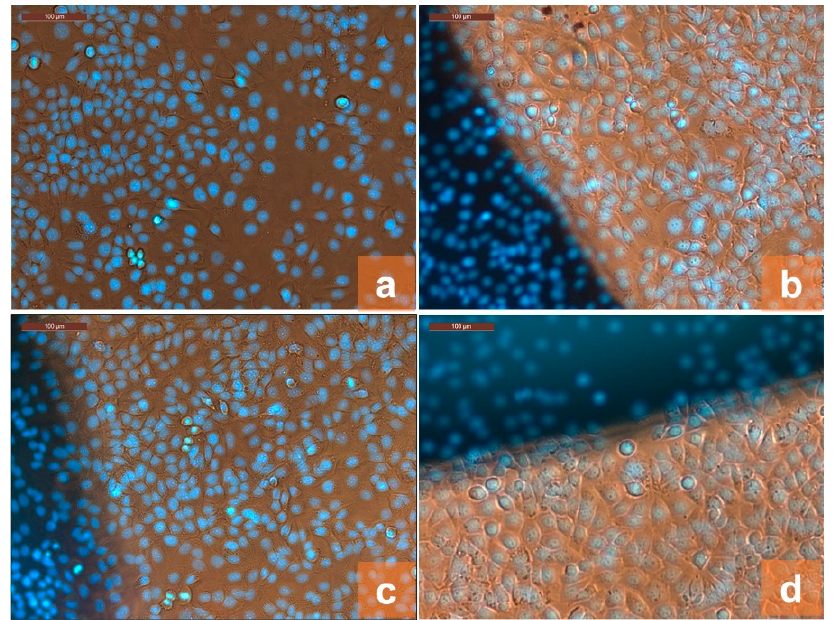
Figure 8. Microscopic images of DAPI-stained cells at 72 h of culturing in contact with PVA/CS-0 ( a ), PVA/CS-1 ( b ), PVA/CS-2 ( c ), and PVA/CS-0 ( d ) at 20× objective magnification. From the images showing the experimental cultures, no differences of cell morphol- ogy were observed between the different compositions of the samples. All analyzed cul- tures contain epithelial cells with a shape typical of the MCF 7 cell line. It is observed that at 72 h of culture, the cells grow in confluent monolayers, with a cell density without